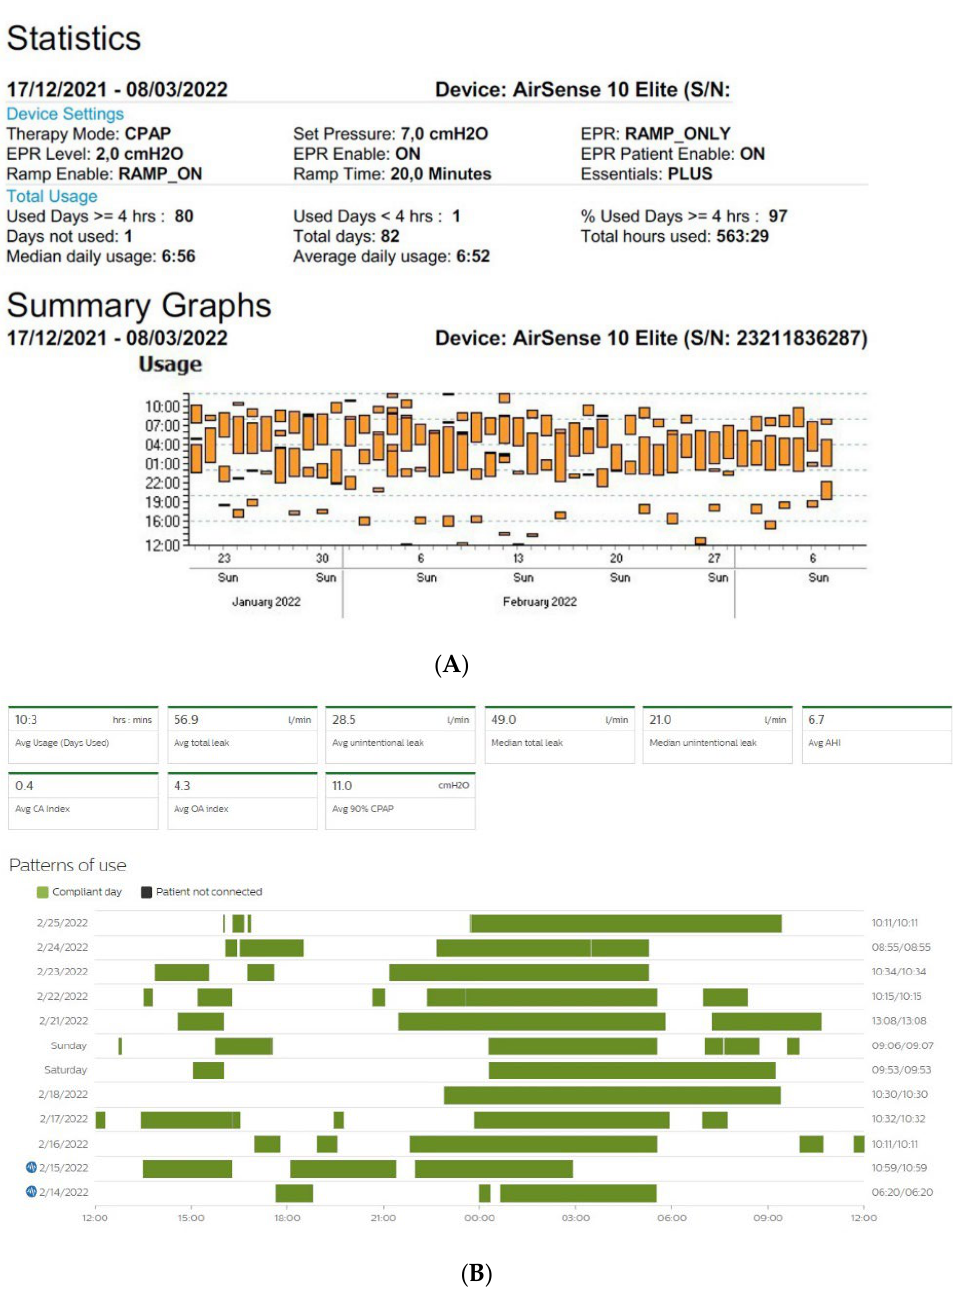
Figure 3. Sleep patterns of CPAP-treated patients suffering from maintenance insomnia. Frequent naps are also observed. CPAP data are collected from Resmed ( A ) and Philips ( B ) devices. AHI: